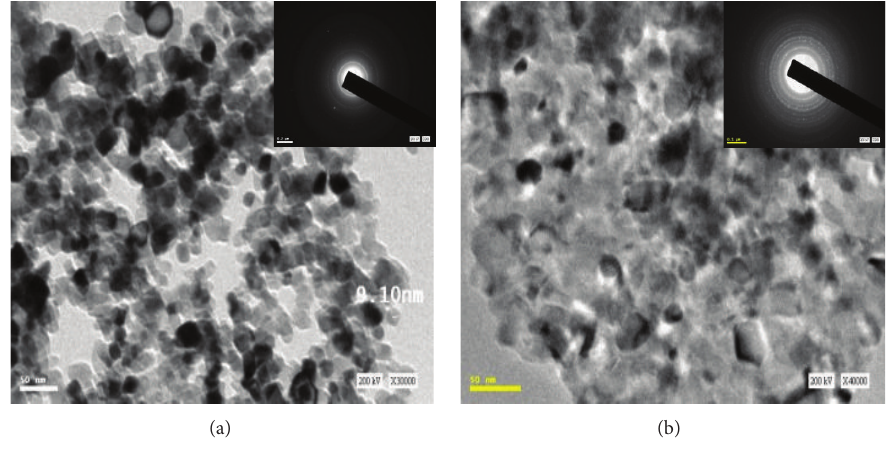
Figure 3: TEM images of the TiO 2 at different